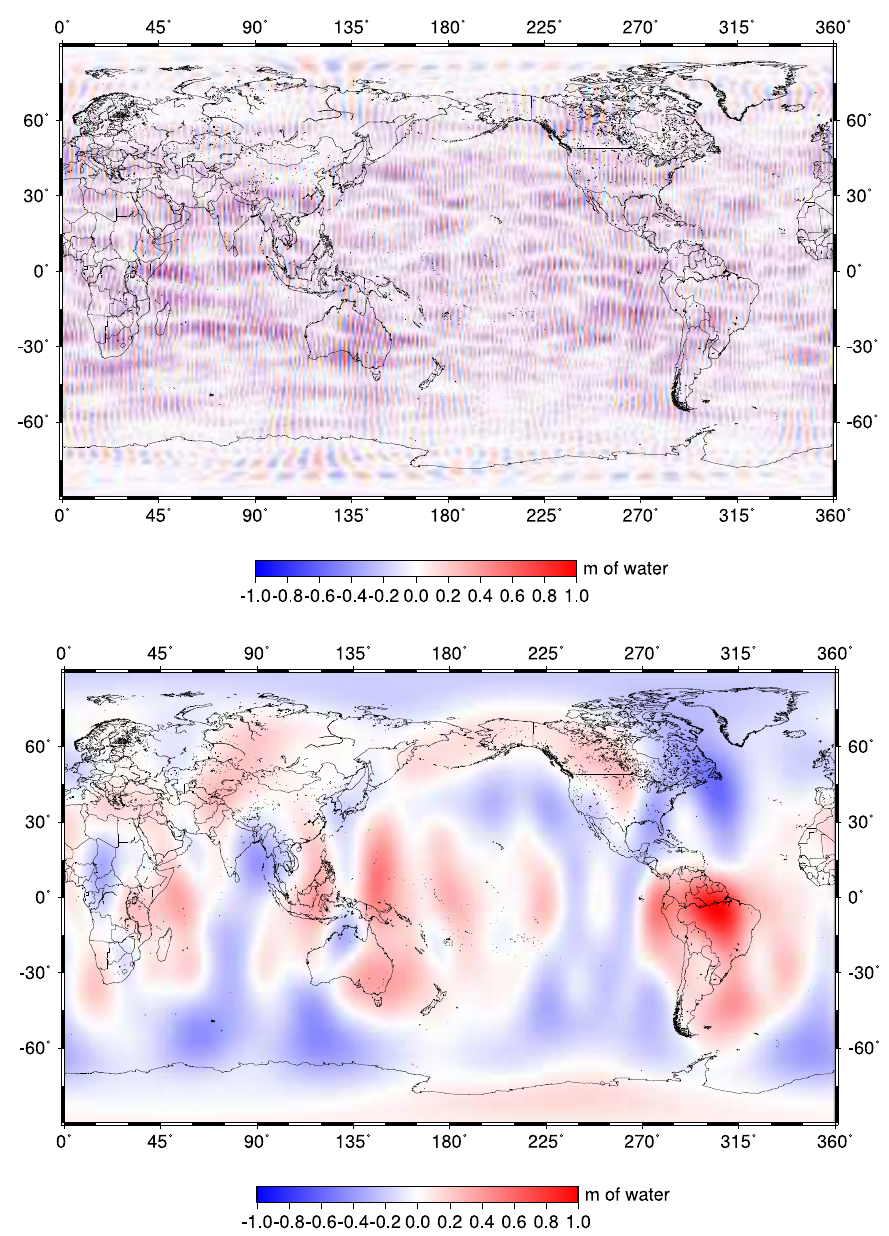
Fig. 1. Global monthly mean water storage variation between April and March 2003 from GRACE. Top panel – without smoothing, Bottom panel – after 1000km Gaussian